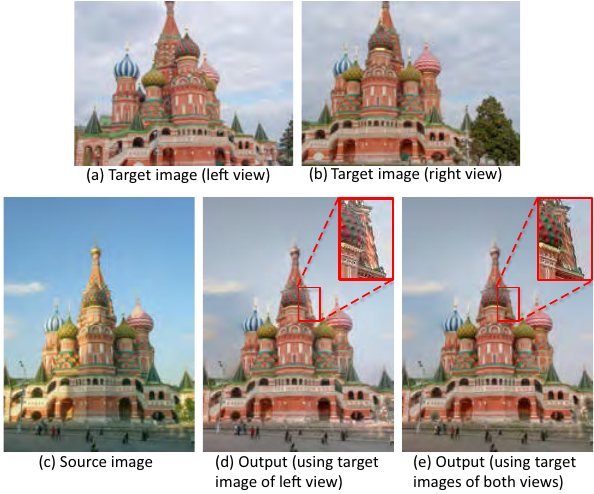
Fig. 4 We extend our method to transfer lighting from multiple target images. While the output using the left target image (d) has inconsistent lighting in some regions, the output using both target images (e) has appropriate local